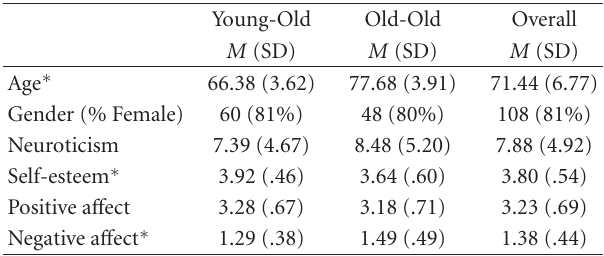
Table 1: Demographic information and individual di ff